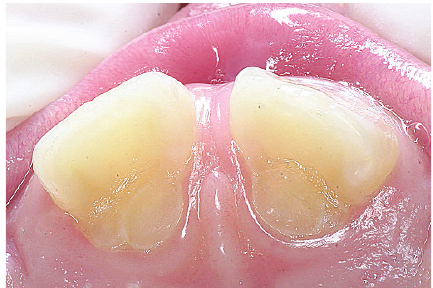
Figure 5: Final aspect of treatment.